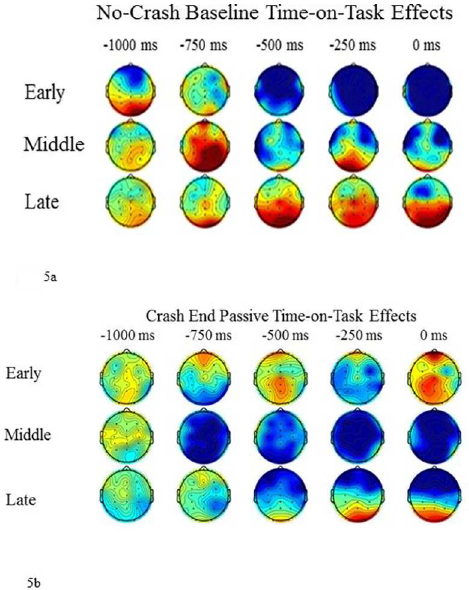
Fig 5. a. Topographic scalp distributionof the evolutionof anticipatory activity of the “Baseline”conditionin the three phases of the Time-on-Task analysis. b. Topographicscalp distribution of the evolutionof anticipatory activity of the ‘Crash End Passive’ conditionin the three phases of the Time-on-Task